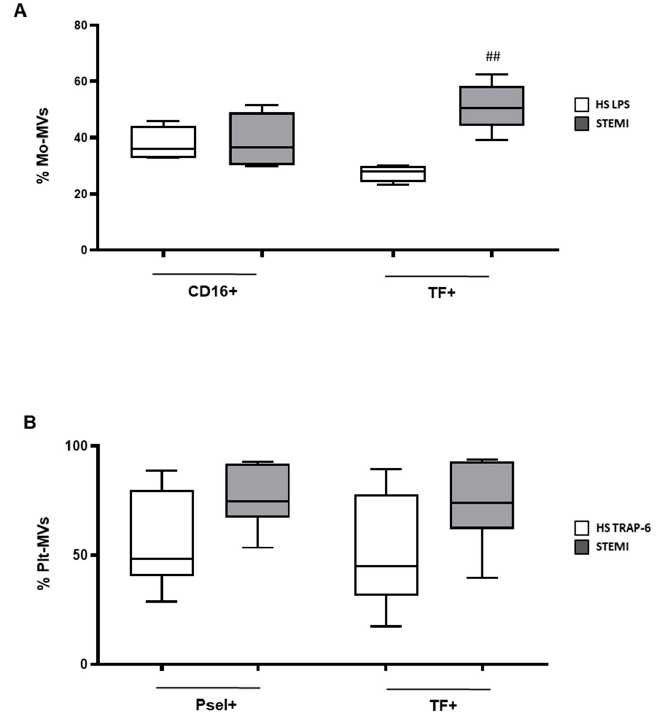
Figure 7. Surface markers expression in MVs released from stimulated monocytes (Mo; A ) and platelets (Plt; B ) of healthy subjects (HS, white box) and STEMI patients (grey box). Data are represented as box and whisker plot (min to max) of the percentage of MVs expressing the indicated markers and analyzed by Mann–Whitney U test. ## p < 0.05 vs. HS.